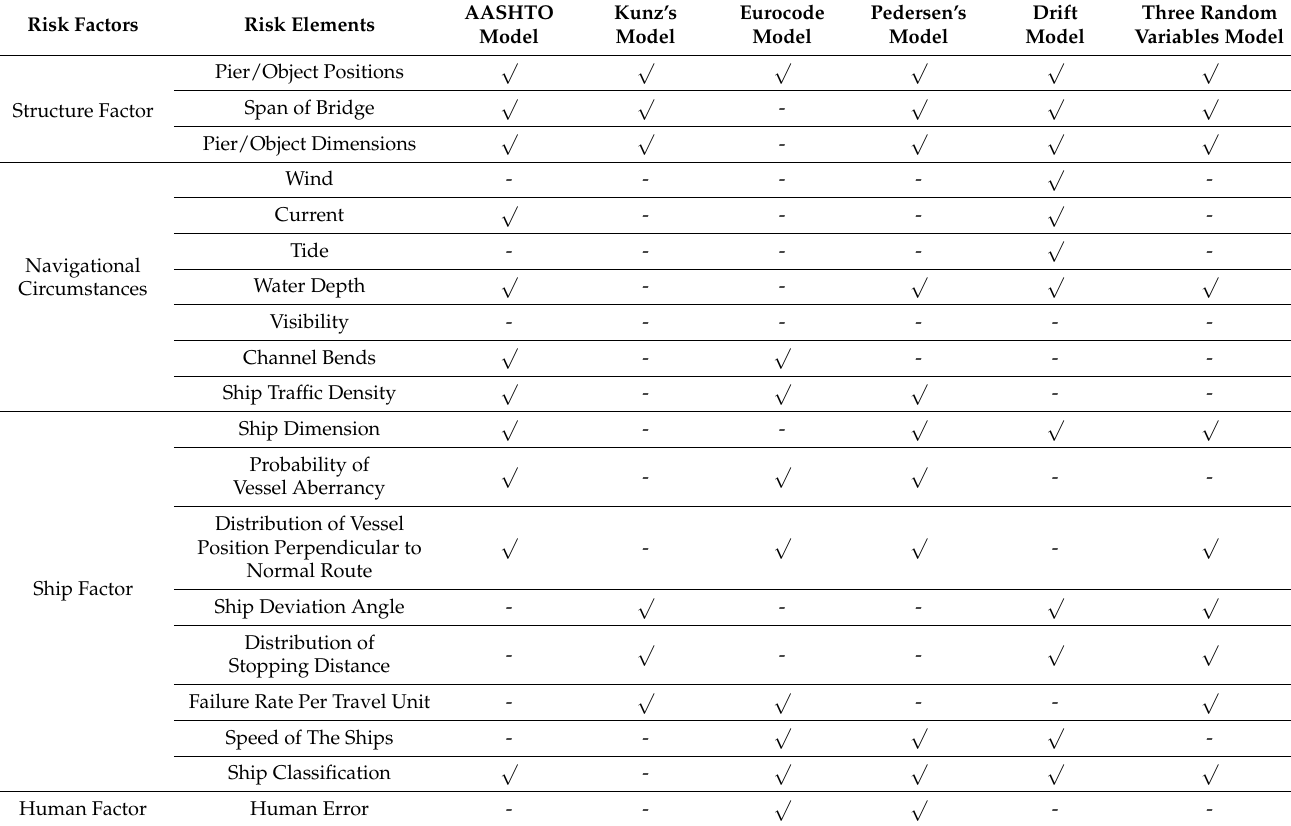
Table 1. Comparison of the factors considered in the